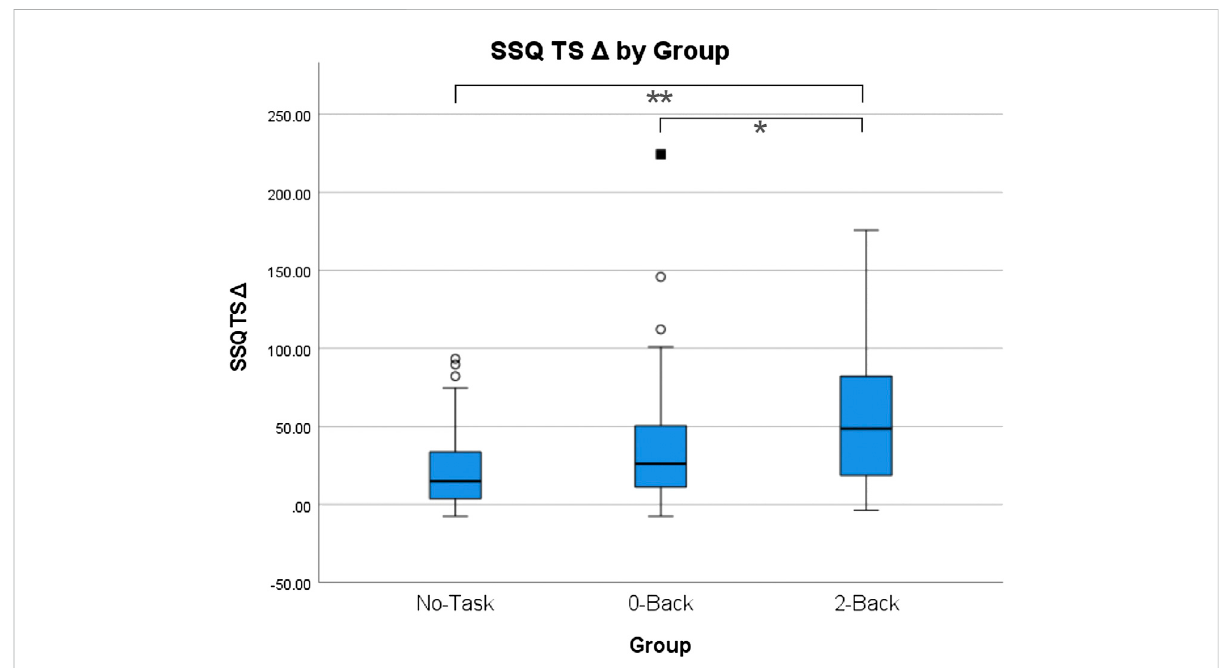
FIGURE 4 Boxplots of SSQ TS Δ by Group. * = signi fi cant difference at a p < 0.05 level; ** = signi fi cant difference at a p < 0.01